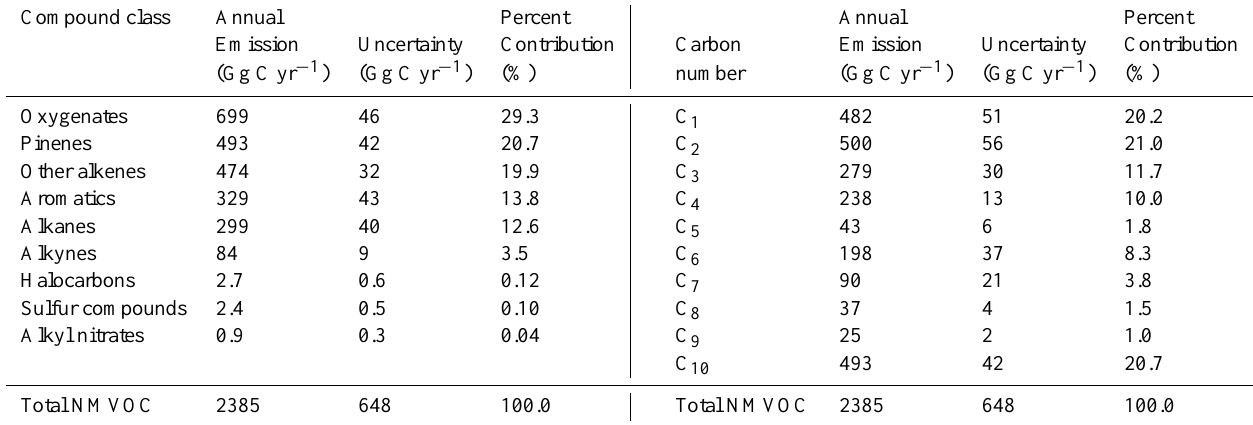
Table 5. Summary of global NMVOC emissions from boreal forest fires by compound class (left four columns) and by carbon number (right four